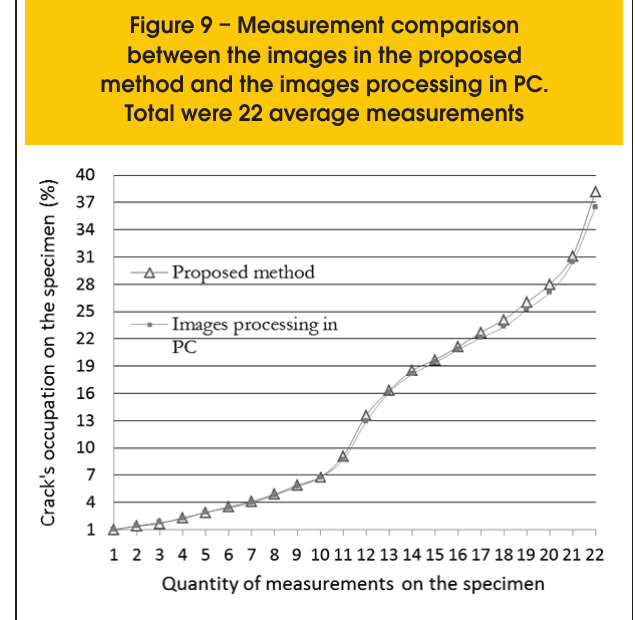
Figure 9 – Measurement comparison between the images in the proposed method and the images processing in